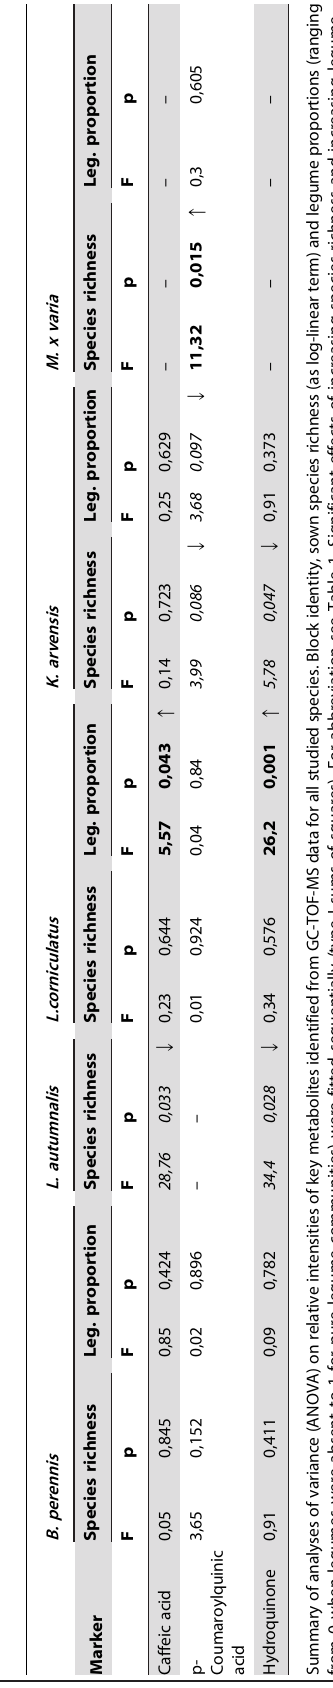
GC-TOF-MS Extraction and